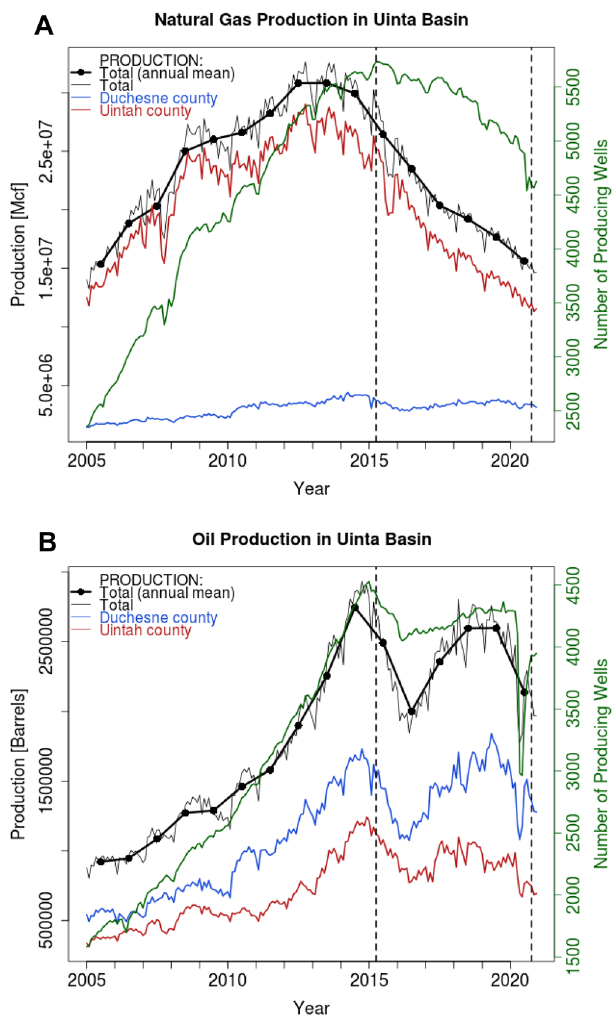
Figure 4. Natural gas or oil production in the Uinta Basin. ( A ) Natural gas production from the Uinta Basin between the years of 2005 and 2020, in units of one thousand cubic feet [Mcf]. The thick black line is the annual mean, while the thin black line is the monthly value. The monthly value is further broken down into production from the Uintah (red) and Duchesne (blue) counties, dominated by gas and oil wells, respectively (Fig. 1). The number of producing gas wells over the same period is in green. The six-year period overlapping with the in-situ CH 4 analysis is between the dashed vertical lines. ( B ) Similar to ( A ), but for oil production in [Barrels] and the number of producing oil wells